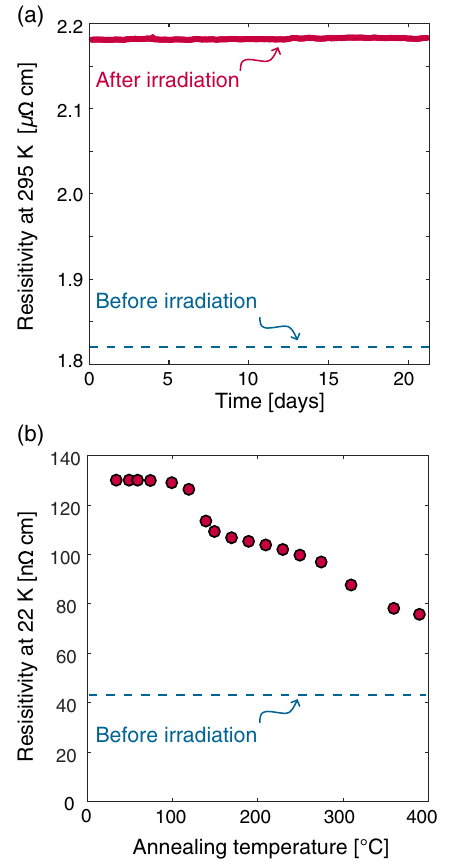
FIG. 17. (a) The room-temperature resistivity of an irradiated PtCoO 2 sample measured over the course of 20 days. (b) The resistivity of an irradiated PtCoO 2 sample measured at 22 K as a function of the annealing temperature, at which the sample was kept for 30